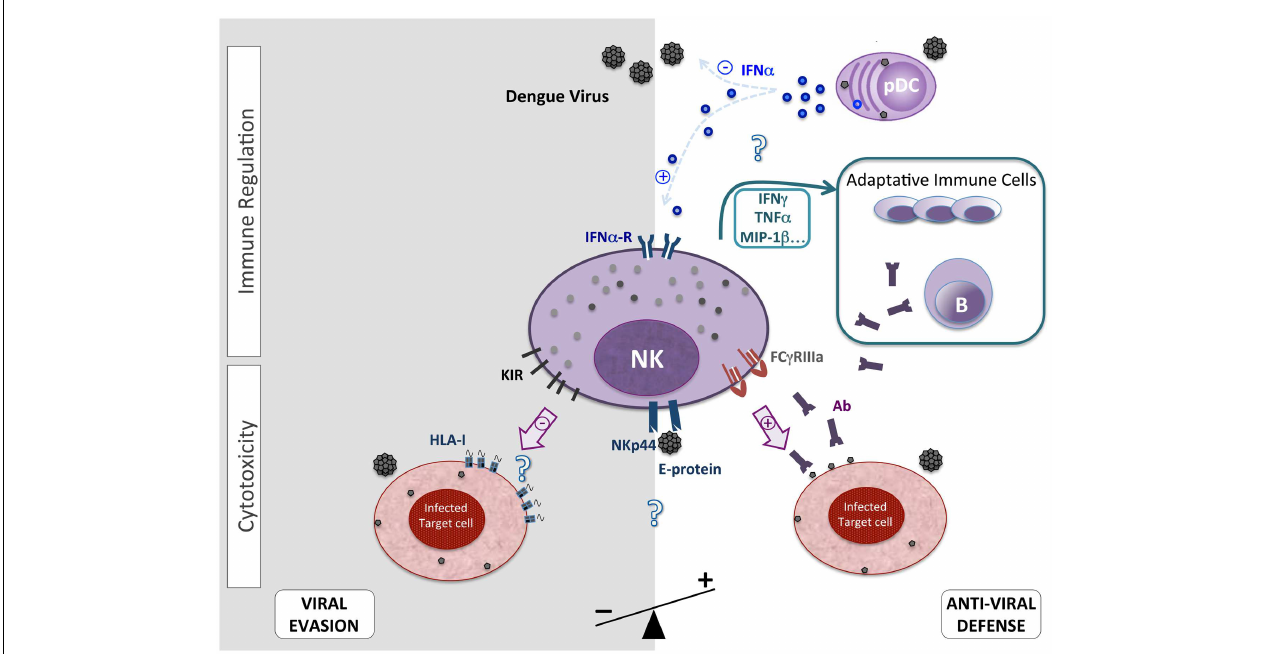
FIGURE 1 | Overview of the suggested NK cell features after acute and primary DENV infection